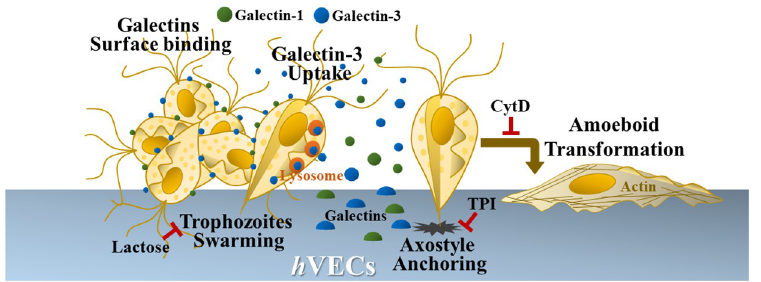
Fig 10. The differential host-parasite interaction of T . vaginalis . On infection, T . vaginalis may trigger the surface expression and secretion of galectins from h VECs. The extracellular galectins may initially bind on the parasite surface, then galectin-3 is internalized and enclosed in the lysosomes inside the trophozoites of adherent isolate. The extracellular galectins bound to the parasite might trigger the aggregation of trophozoites on h VECs, as this is diminished in the presence of lactose. In the adherent isolate, the predominant flagellate-amoeboid transition, as well as cytoadherence, were simultaneously suppressed by CytD, speculating that actin cytoskeleton-based behavior may mediate cytoadherence. When axostyle microtubule assembly was disturbed by TPI, the axostyle anchoring was abolished with the reduced cytoadherence, suggesting that axostyle anchoring might be an early event required for cytoadherence. For T . vaginalis , it is speculated that the cytoskeleton and cell surface adhesion molecules may coordinate their cytoadherence, so these factors should be considered in the study of host-parasite interactions and provide new insights into the host colonization of T . vaginalis